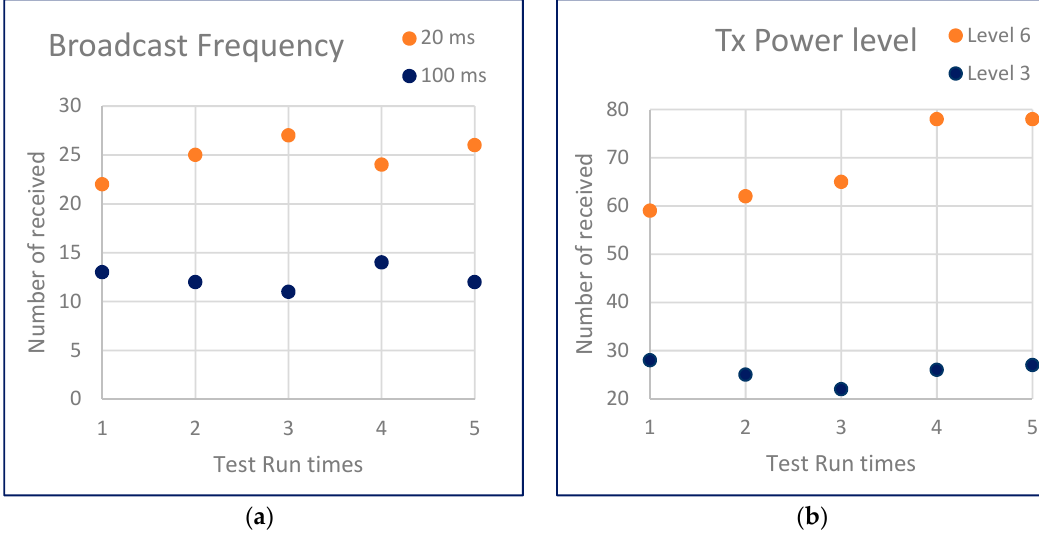
Figure 9. The experiment of ( a ) the five times broadcast frequency test; and ( b ) the five times Tx Power level test.